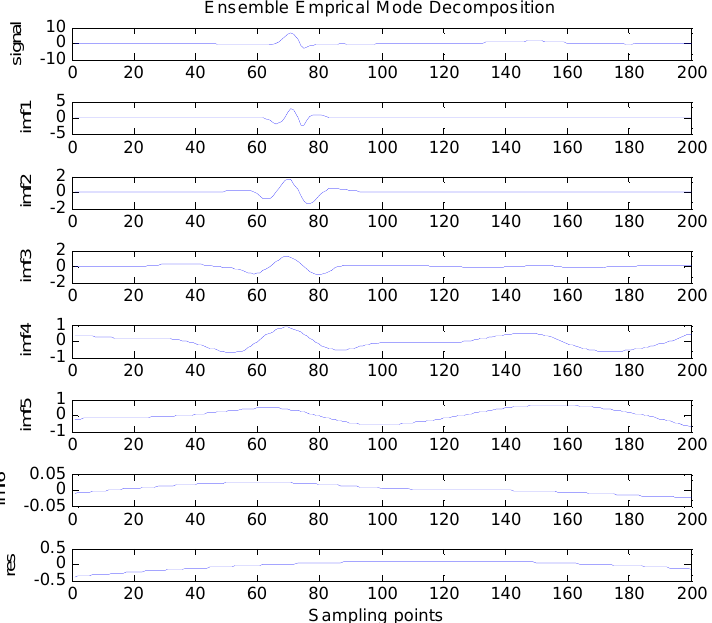
Figure 12. EEMD decomposition result of record 302 m ECG